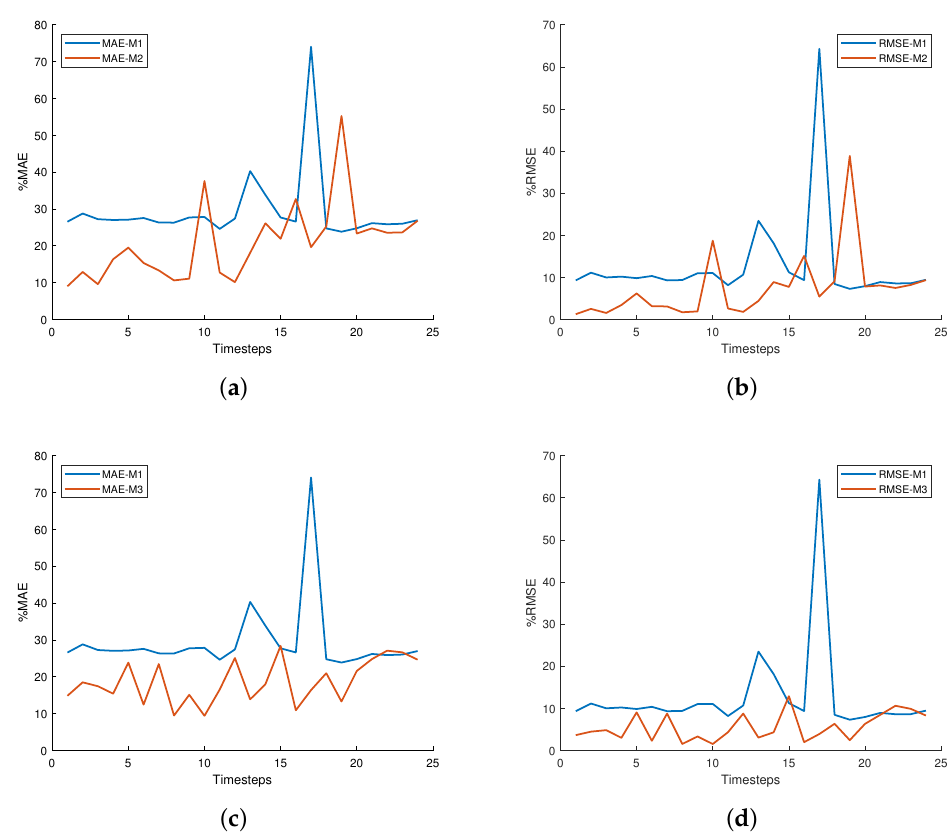
Figure 5. Comparison of the single- versus multiple-point approach: ( a ) single vs. multiple inputs; ( b ) single vs. multiple inputs; ( c ) single vs. multiple outputs; ( d ) single vs. multiple